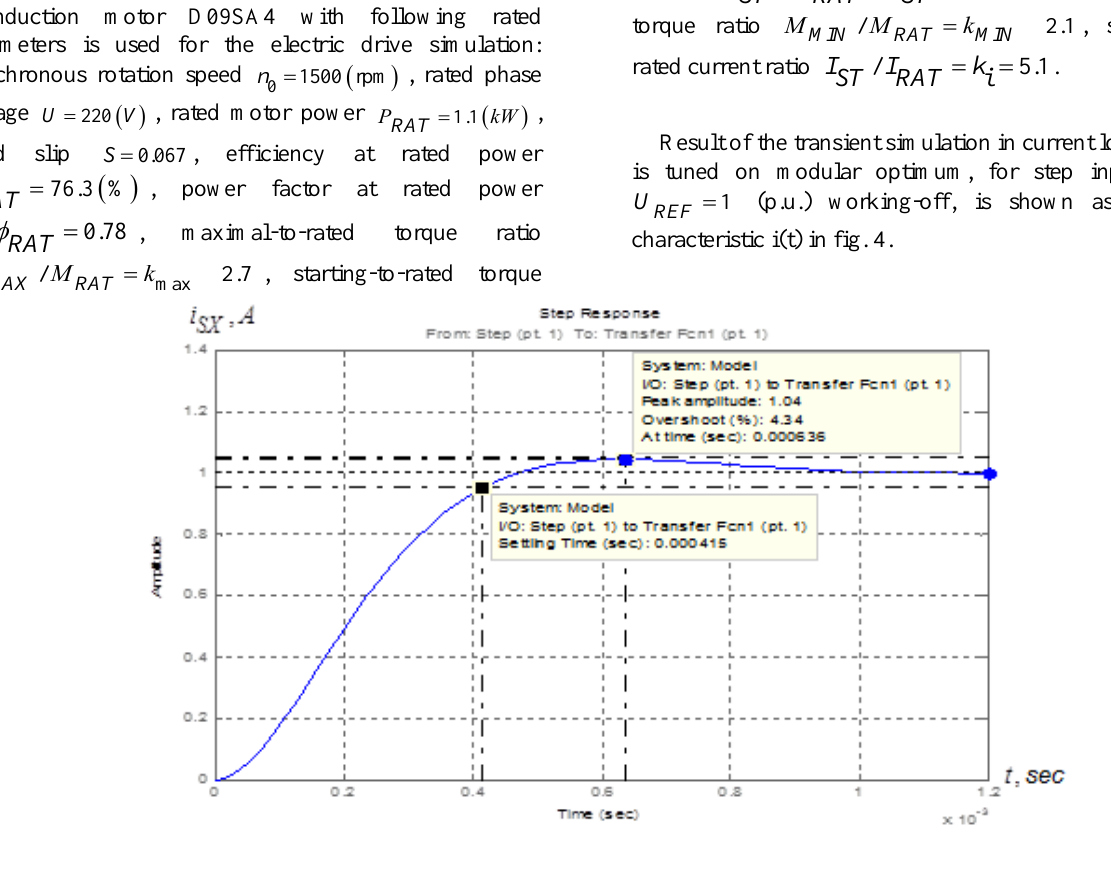
Figure 4 . Current loop transient characteristic